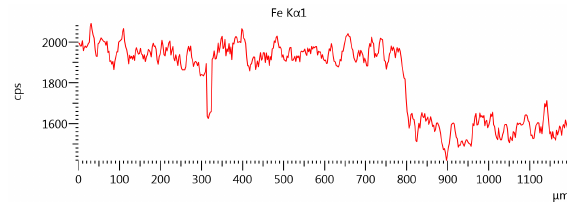
Figure 13: Ferrite amount alongside measurement line